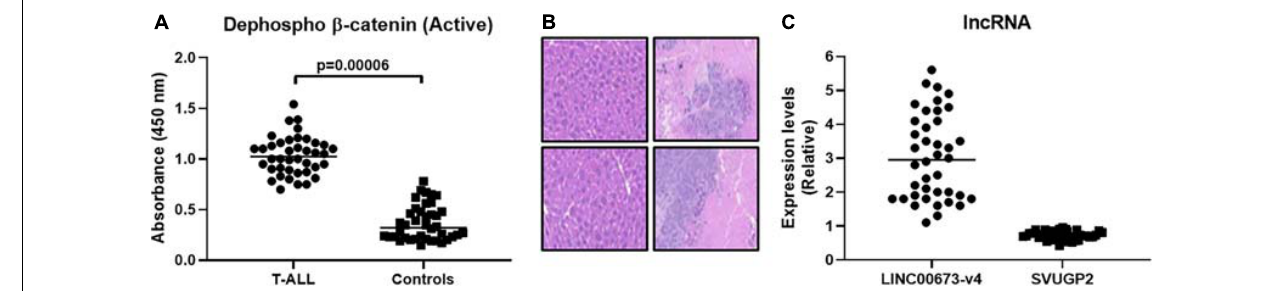
FIGURE 1 | β -catenin expression is elevated in T-ALL patients and favors hepatic metastasis. (A) β -catenin expression (active dephosphorylated form) was evaluated, using ELISA, in T-ALL patients ( n = 40) and compared with that in healthy volunteers ( n = 40). (B) Flow sorting was performed to segregate β -catenin-positive and β -catenin-negative fractions which, after culture, were injected (50,000) into the tail veins of mice ( n = 6, each), intra-venously. Mice were euthanized after 7 weeks and hepatic metastases evaluated. Representative immunohistochemistry images are shown (Left top and bottom: β -catenin-negative and Right top and bottom: β -catenin-positive). (C) lncRNAs (LINC00673-v4 and SVUGP2) were evaluated for their expression in β -catenin-positive and β -catenin-negative fractions and the expression levels in β -catenin-positive, relative to β -catenin-negative fractions, are shown.